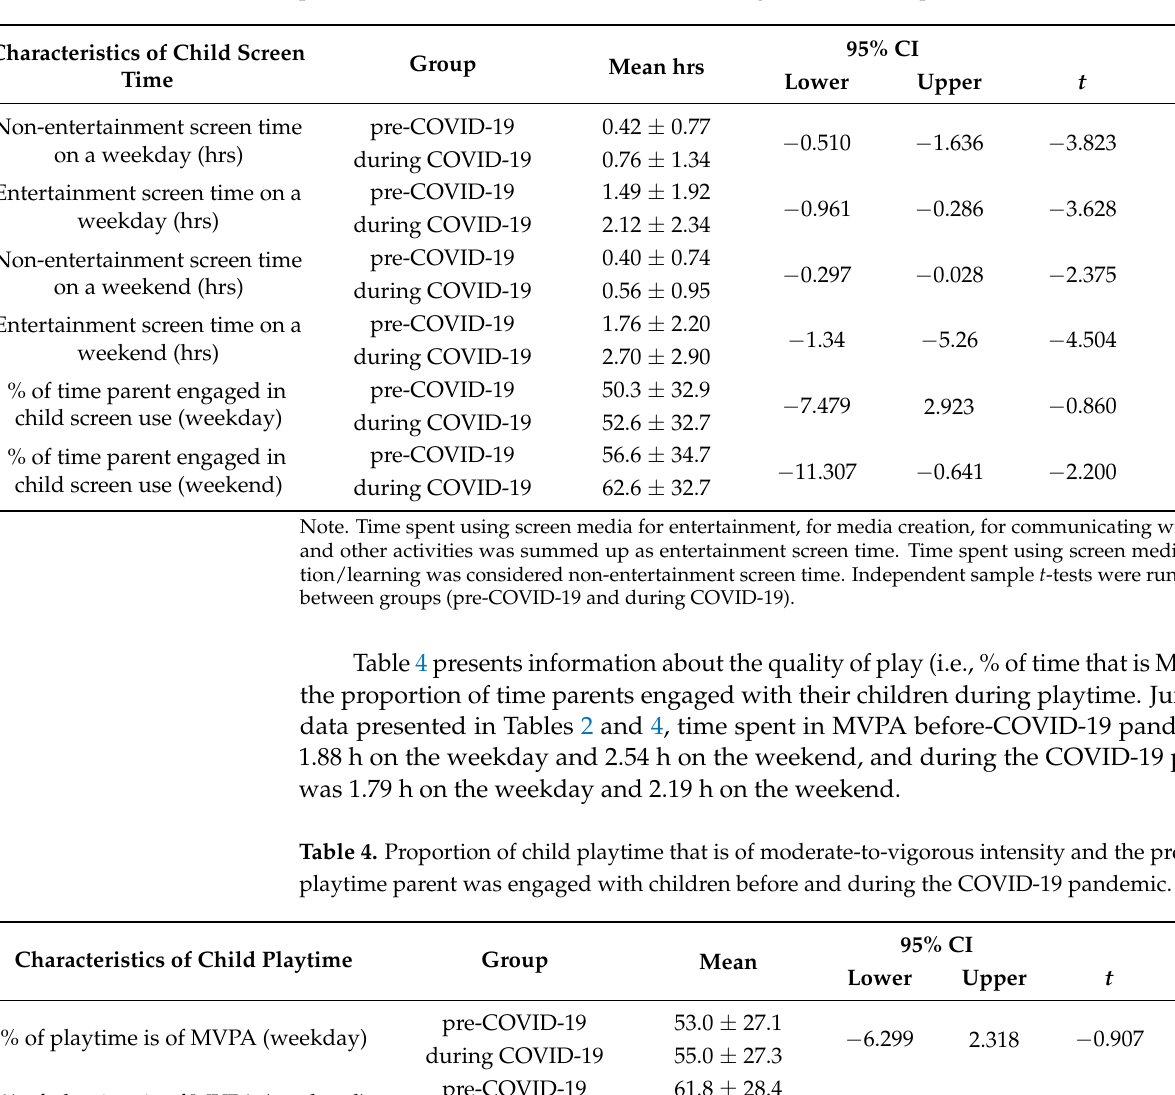
Table 3. Non-entertainment and entertainment screen time of preschool children and parent accom- paniment in child screen use before and during the COVID-19 pandemic.